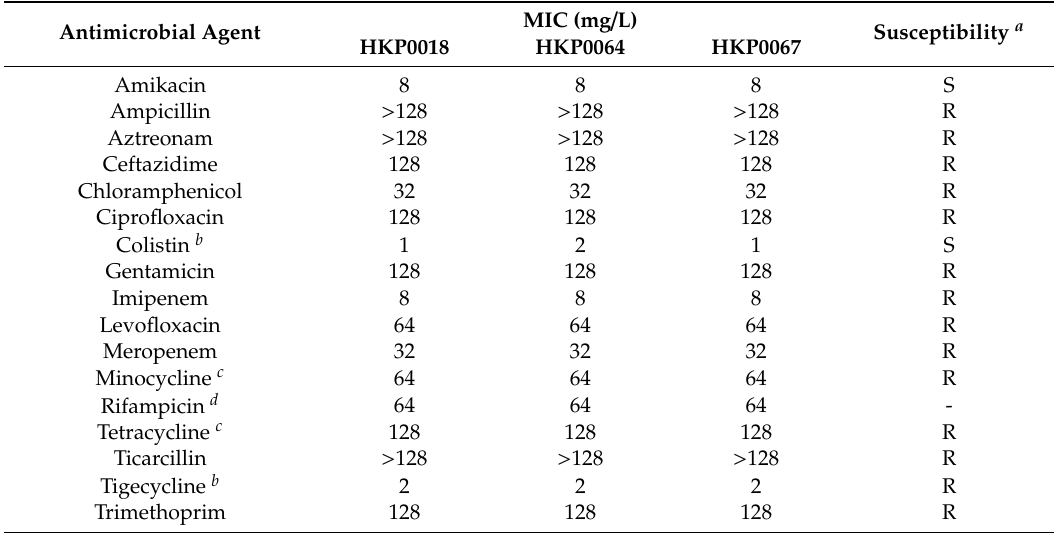
Table 2. Antimicrobial susceptibility of the three K. pneumoniae isolates.